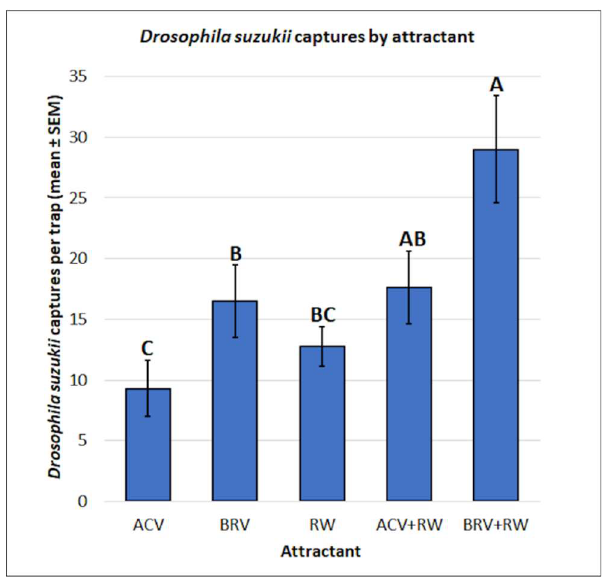
Figure 3. Mean ( ± SEM) Drosophila suzukii captures by attractant type. Different letters represent statistically significant differences ( p < 0.05, Tukey’s HSD test) between attractant solutions.